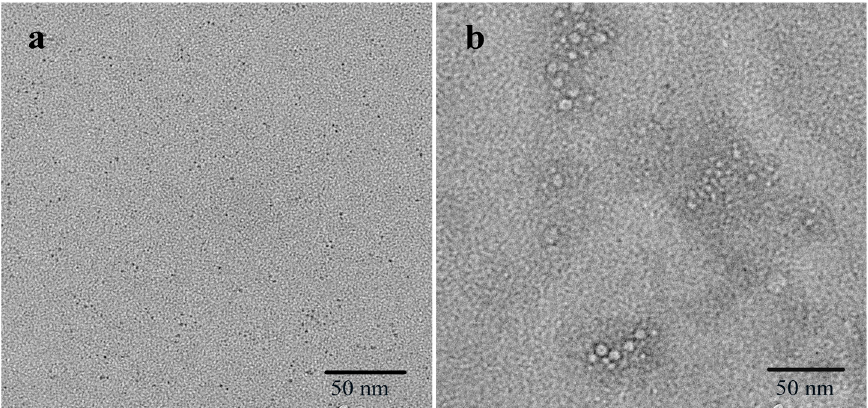
Figure 1. Transmission electron microscopy (TEM) images of the bovine-serum-albumin-stabilized Cu nanoclusters (BSA-Cu NCs) in the absence ( a ) and presence of 100 µM gossypol ( b ).